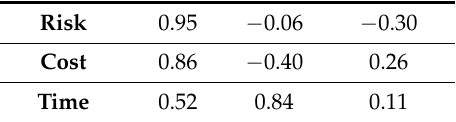
Table 7. Results of implementing PCA on each